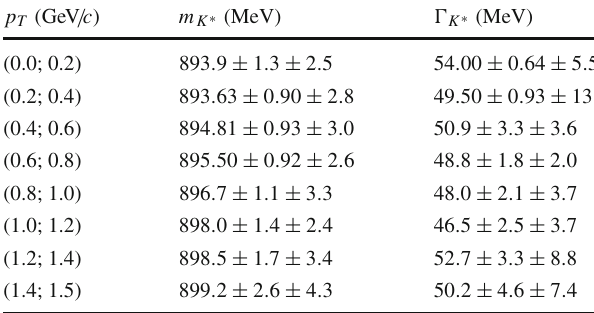
Table 2 Numerical values of mass and width of K ∗ ( 892 ) 0 mesons fitted in 0 < y < 0 . 5 and presented in Fig. 8. The first uncertainty is statistical, while the second one is